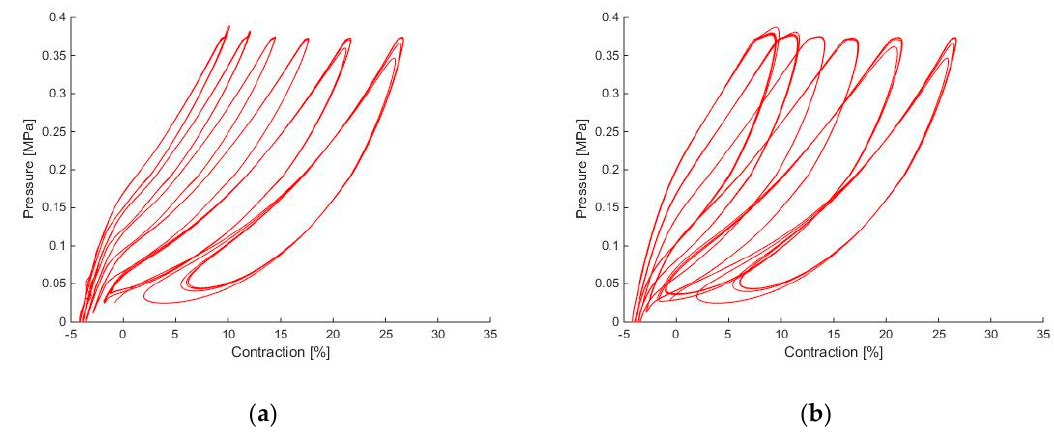
Figure 6. Model simulation: ( a ) existing model and ( b ) proposed model.